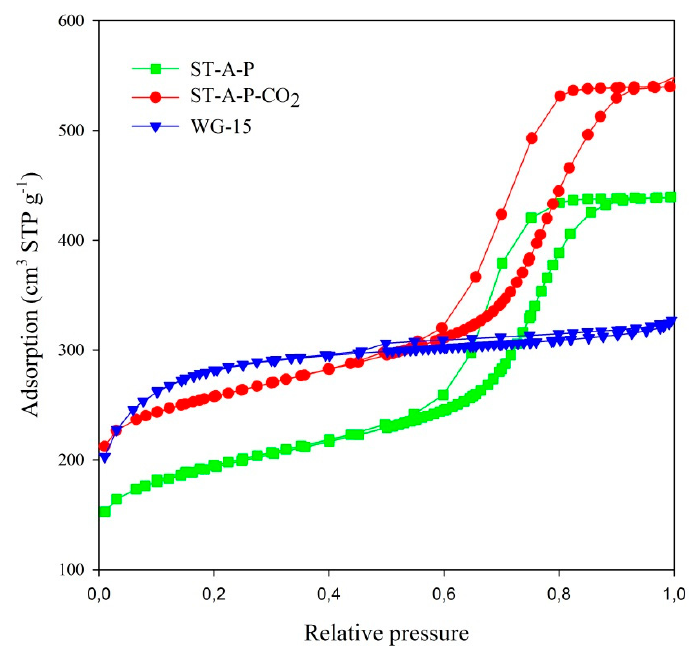
Figure 3. Nitrogen adsorption isotherms for carbon materials studied.